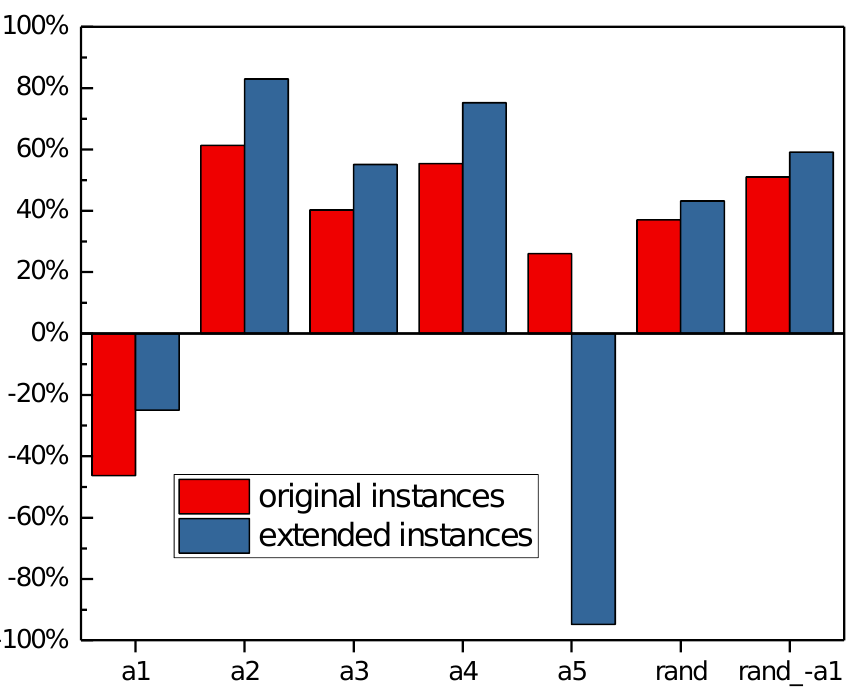
Figure 9. The percentages that A2C outperforms SDR considering average total tardiness cost on the original and extended